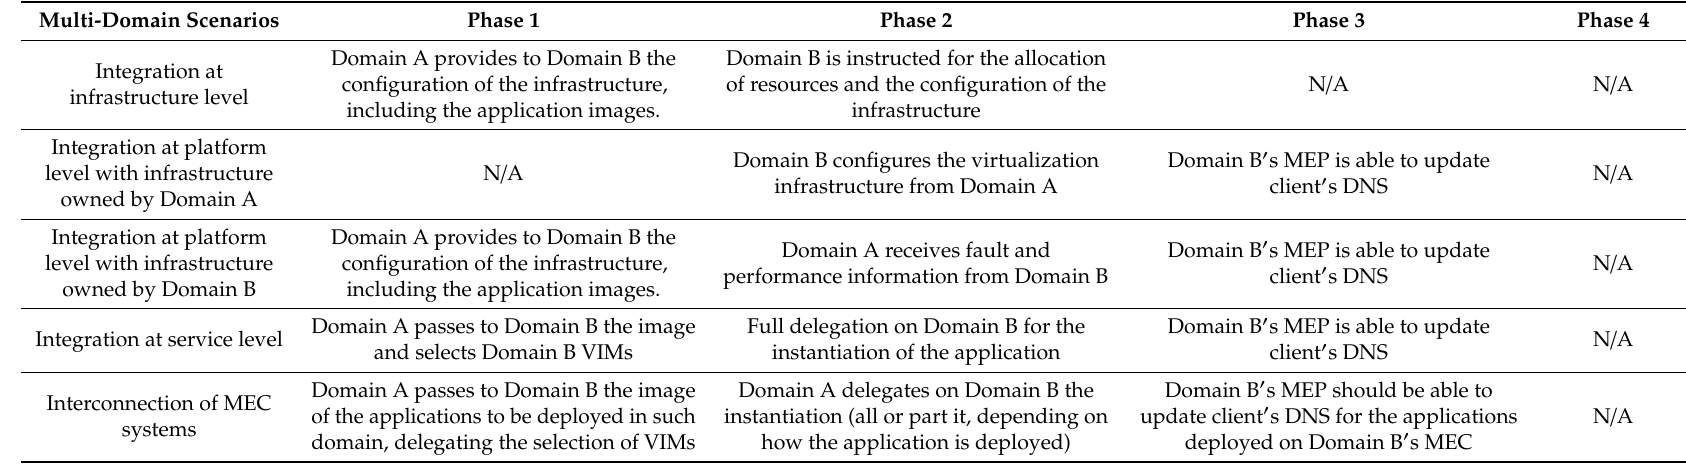
Table 4. Summary of interactions between MEC domains in the deployment of an MEC application per multi-domain alternative